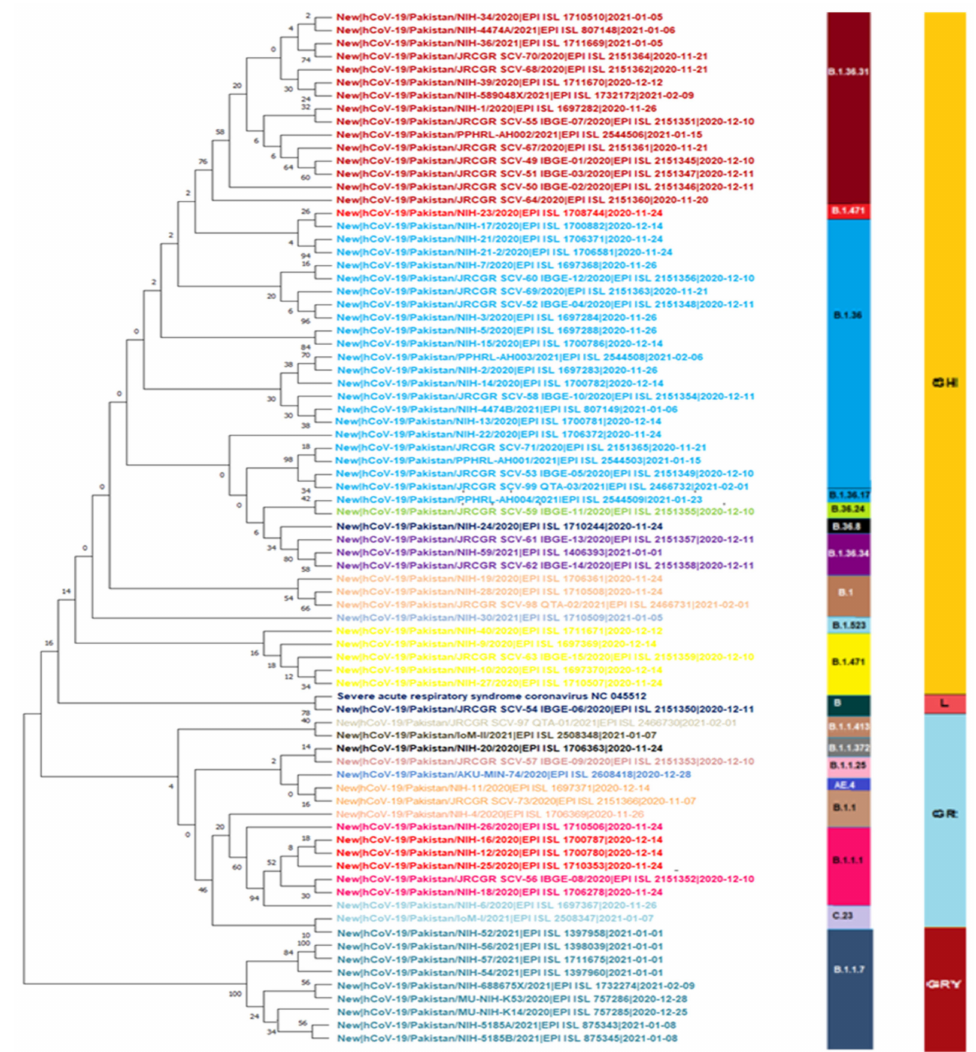
Figure 10. Maximum Likelihood phylogenetic tree of SARS-CoV2 genome during second wave representing 19 lineages (B.1.36.31, B.1.471, B.1.36, B.1.36.17, B.36.24, B.36.8, B. 1.36. 34, B.1, B.1.523, B.1.471, B, B.1.1.413, B.1.1.372, B.1.1.25, AE. 4, B.1.1, B.1.1.1, C.23, B.1.1.7) and 4 clades (GH, L, GR, GRY) in second